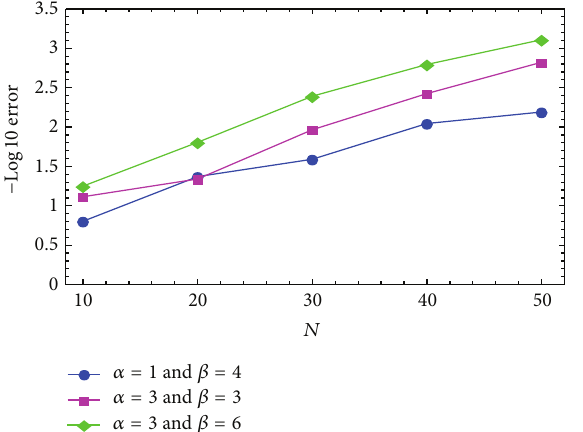
Figure 7: Maximum absolute error (case II) by using MGLT (Radau) with various choices of 𝑁